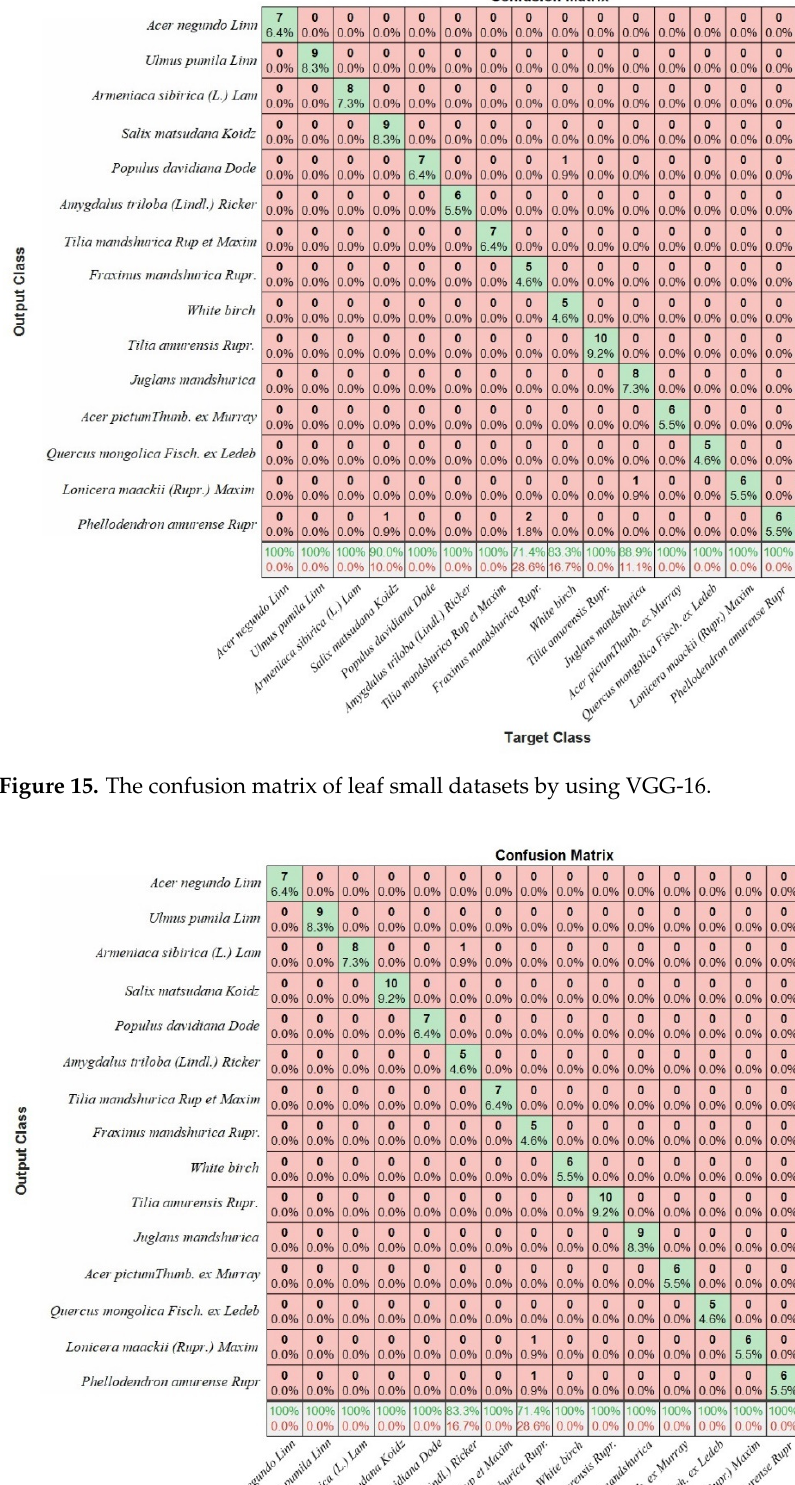
Figure 14. The confusion matrix of leaf small datasets by using GoogLeNet.